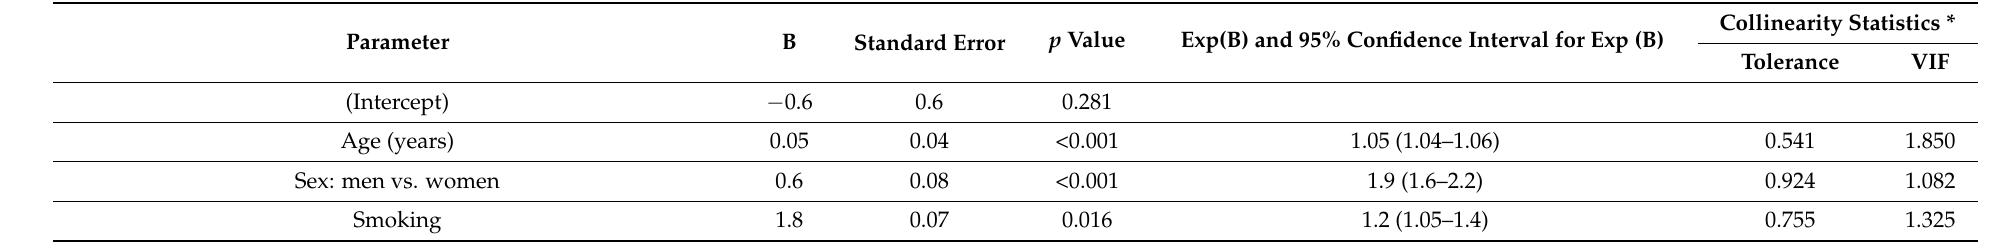
Table 5. Multivariate logistic regression analysis for hypertension diagnosis as the dependent variable with statistically significant independent parameters among the whole study population ( N =